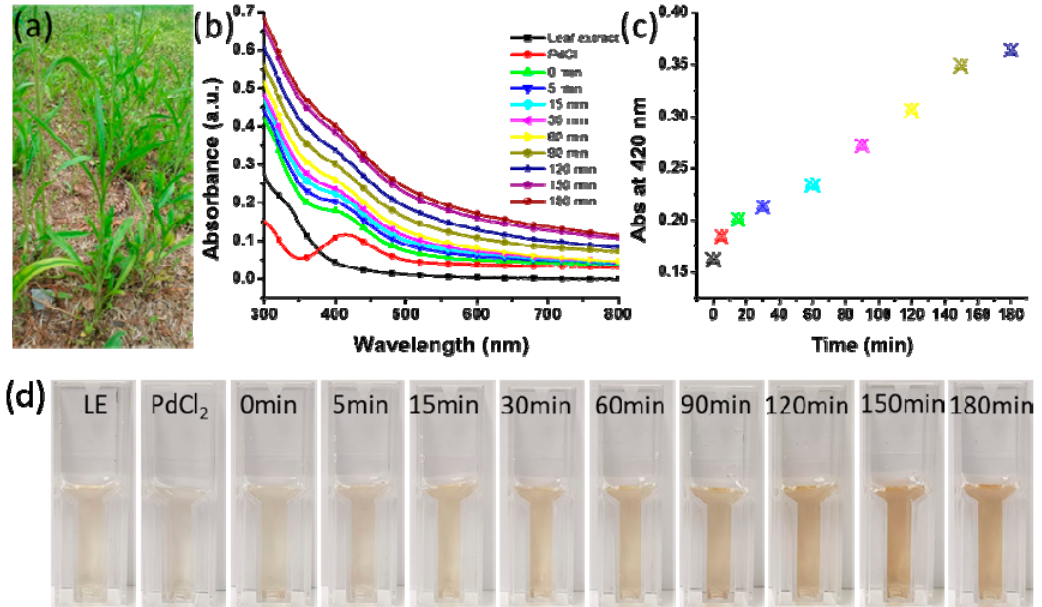
Figure 1. Biosynthesis of palladium nanoclusters (PdNCs): ( a ) Erigeron canadensis L.; ( b ) UV/Vis spectra of the leaf extract, palladium chloride, and biosynthesis of PdNCs; ( c ) Absorbance at 400 nm as a function of time; ( d ) The impact of incubation time on the color of reaction mixture (LE: leaf extract).